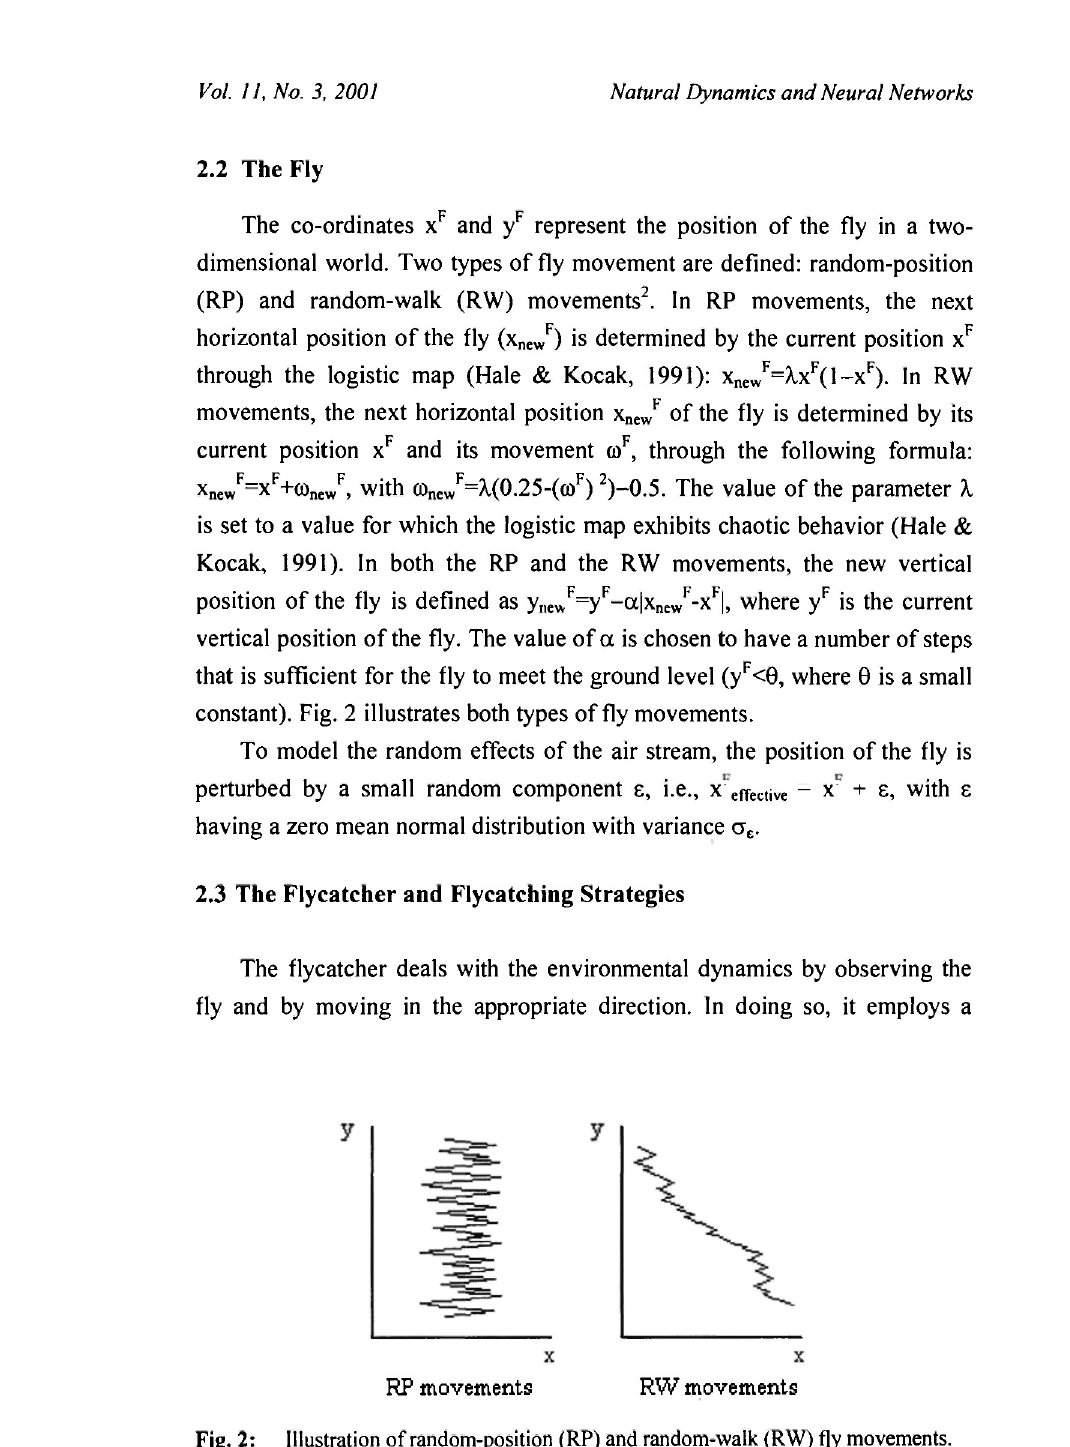
Fig. 2: Illustration of random-position (RP) and random-walk (RW) fly